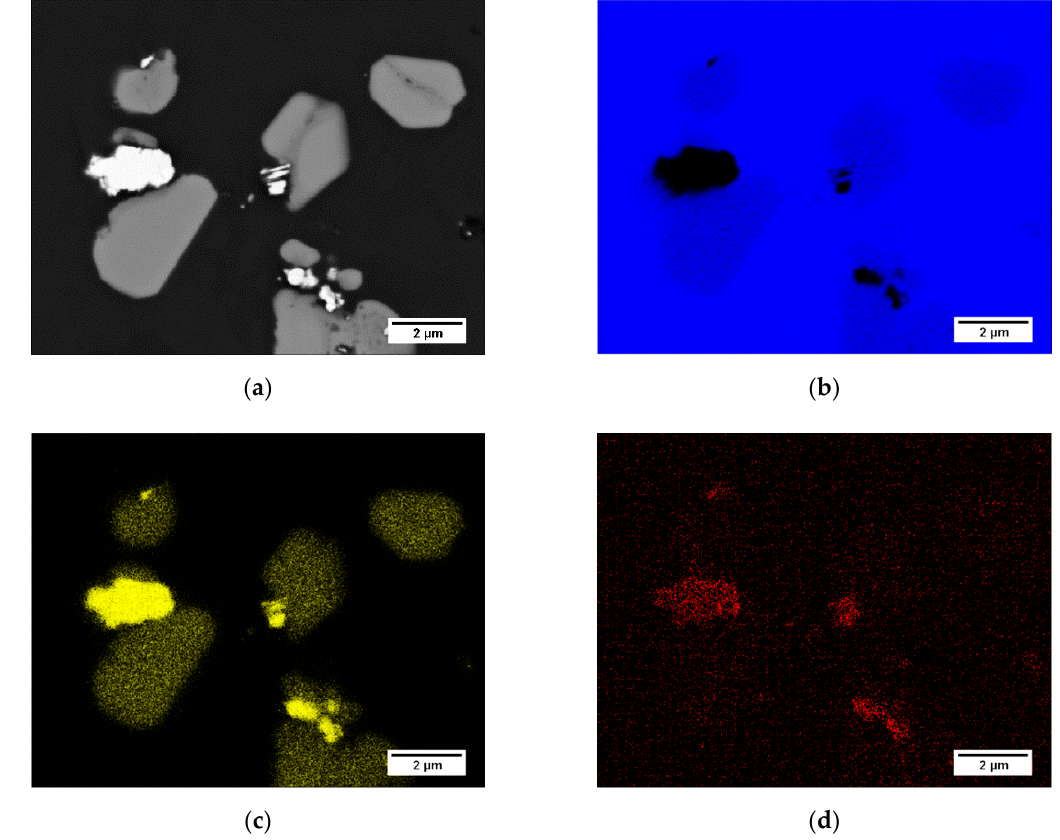
Figure 4. ( a ) One area of the composite in which the two types of particles are observed (white and light gray particles). EDS map analysis illustrating the distribution in that selected zone of ( b ) Al, ( c ) W and ( d ) C.